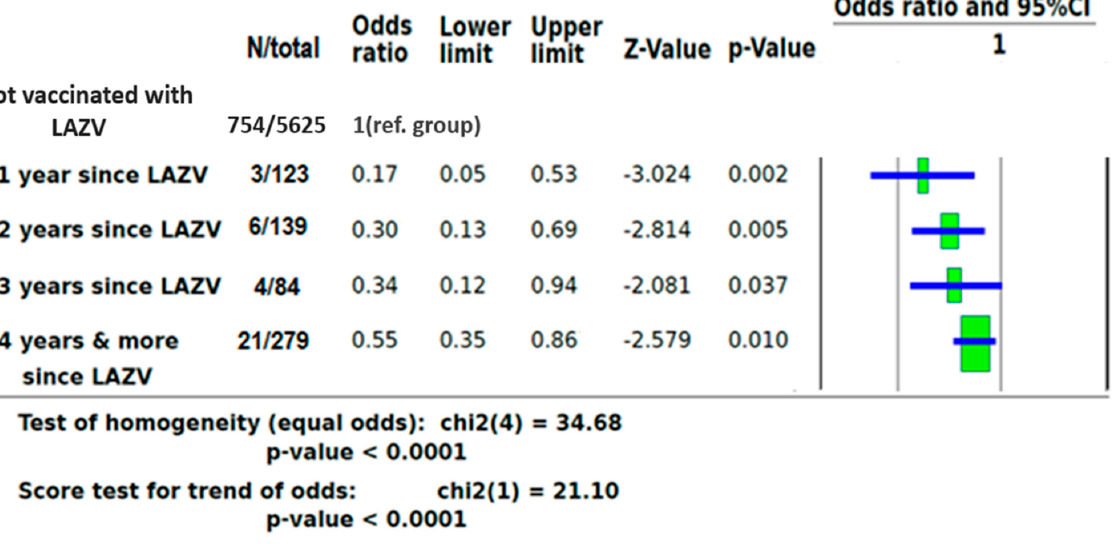
Figure 2. ORs of COVID ‐ 19 infection based on time of LAZV vaccination before PCR testing.